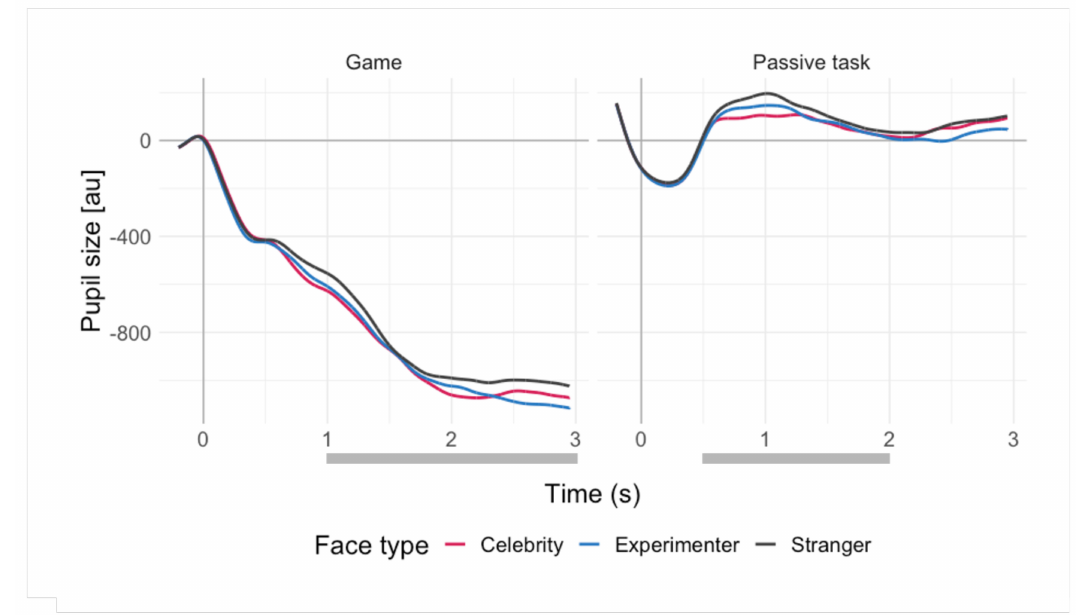
Figure 1. Average pupil sizes (in arbitrary units) in response to stimuli in both tasks across face types (celebrity, experimenter, stranger). The averages are aligned at time 0, which marks the onset of a stimulus presentation (the 200 ms prior to this point comprise the baseline). Grey lines mark the time window used in analyses. Note that the responses are grouped for face types for the purposes of visualisation only (the analyses were conducted with subjective ratings of familiarity and social